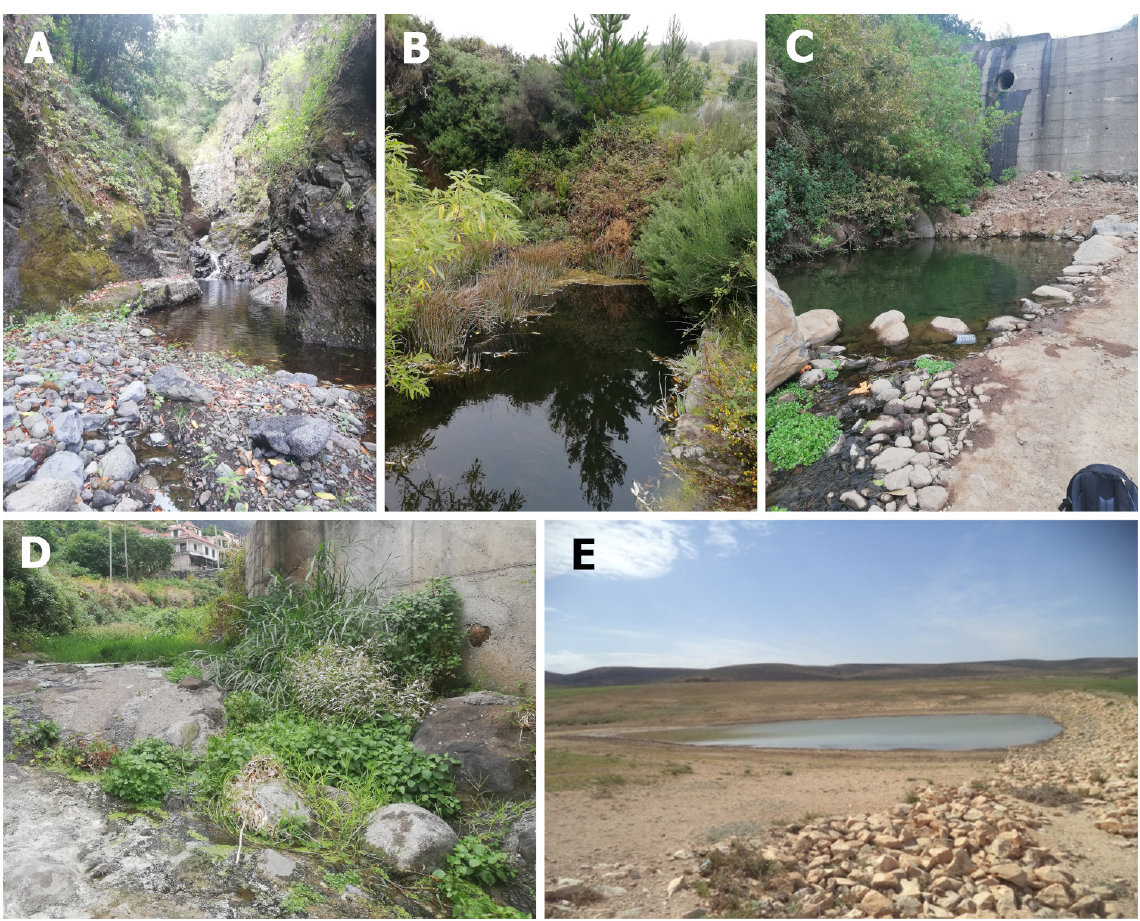
Fig. 6. Habitat variation in Eucyclops azorensis Defaye & Dussart, 1991. A−D . Madeira, Portugal. E . Tébessa, Algeria. A . Ribeiro de Frio, flowing water. B . Seminatural freshwater pond. C . Ribeira de São João, nearly standing water. D . Ribeira de Machico, flowing water. E . Brackish pond at Ain